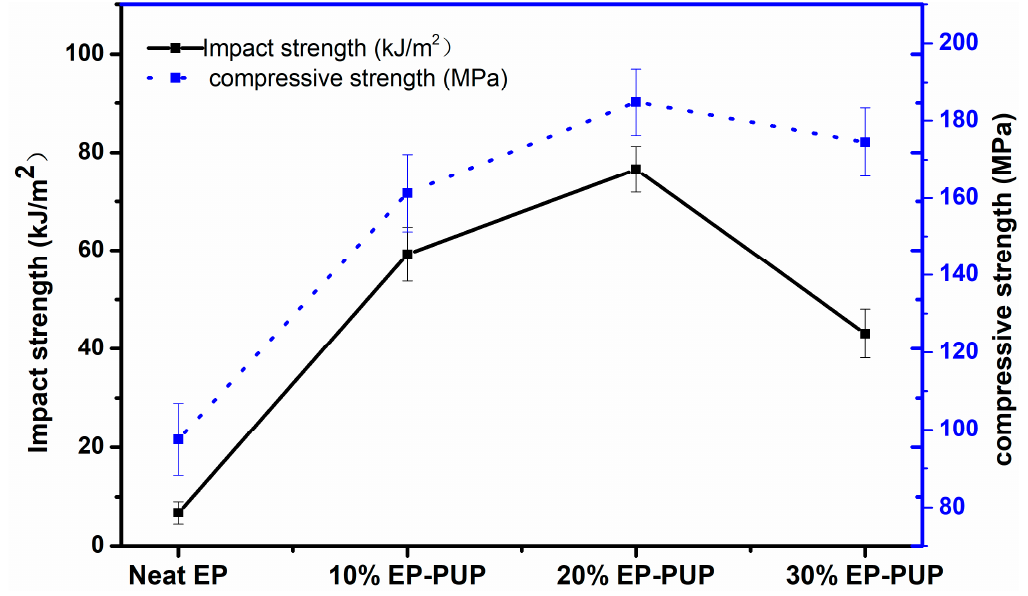
Figure 3. Impact toughness of the modified epoxy resins.